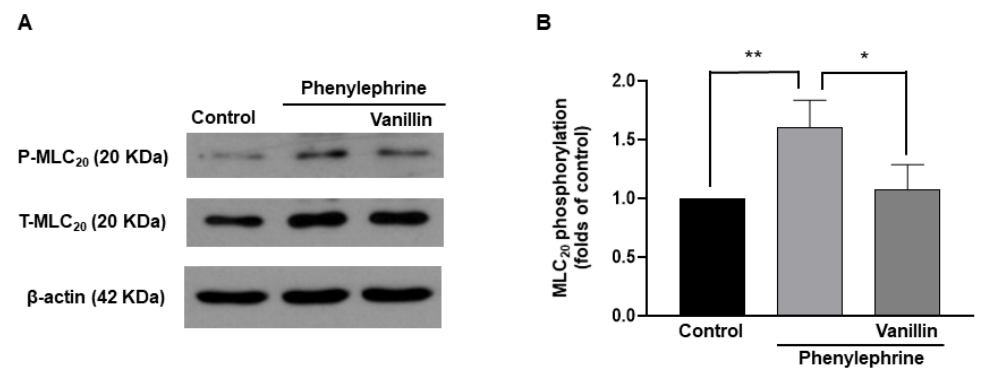
Figure 7. Effect of vanillin on the phosphorylation of MLC 20 . Representative Western blot analysis for phosphorylated MLC 20 (P–MLC 20 ) and total MLC 20 (T–MLC 20 ) in control VSMCs, VSMCs treated with phenylephrine (5 µM), and VSMCs co-treated with phenylephrine (5 µM) and vanillin (3 mM), ( A ). Quantitative data for phosphorylated MLC 20 ( B ). n = 4, * p < 0.05, ** p < 0.005.